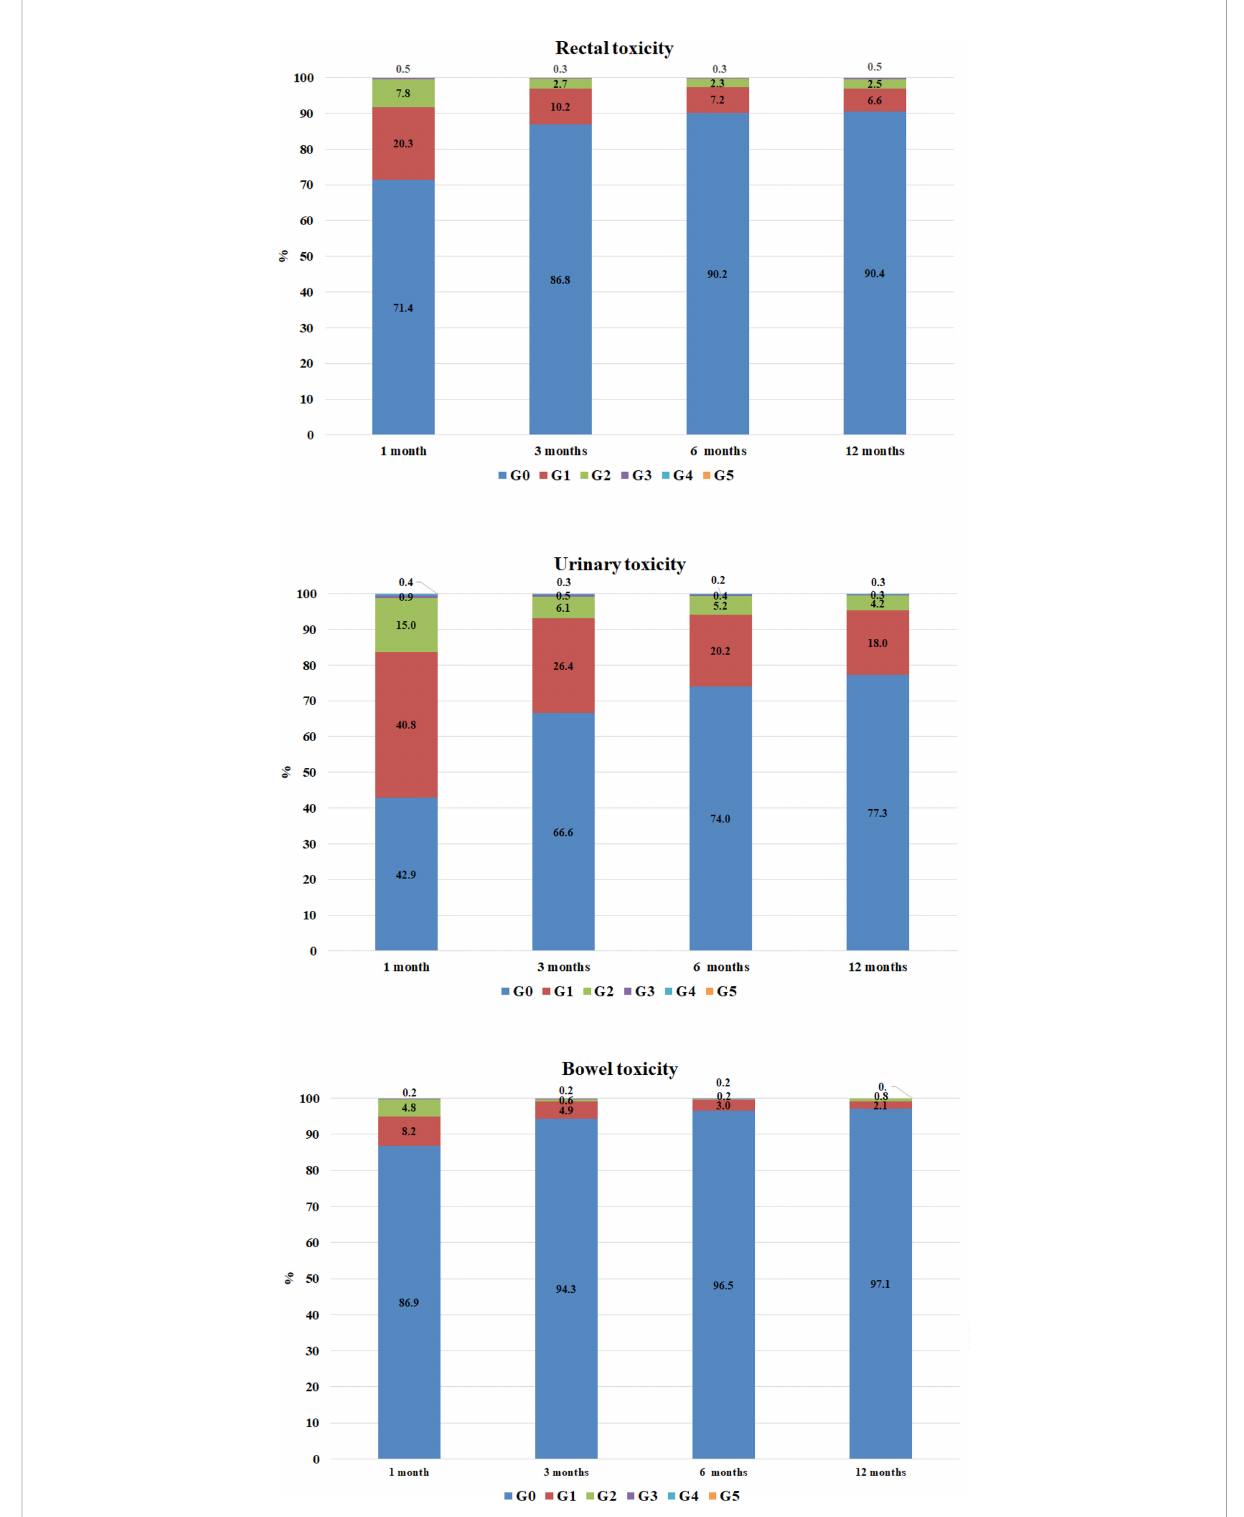
FIGURE 3 Rectal and urinary and bowel toxicity in the overall population, by time. Rectal toxicities: data available at 1 month for 990 patients, at 3 months for 965, at 6 months for 925, at 12 months for 762 patients. Urinary toxicities: data available at 1 month for 990 patients, at 3 months for 965, at 6 months for 926, and at 12 months for 762